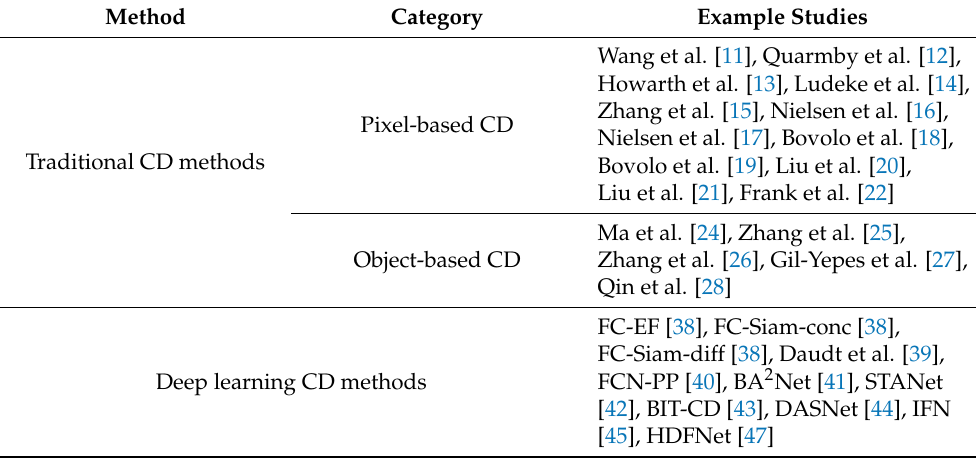
Table 1. Summary of contemporary CD